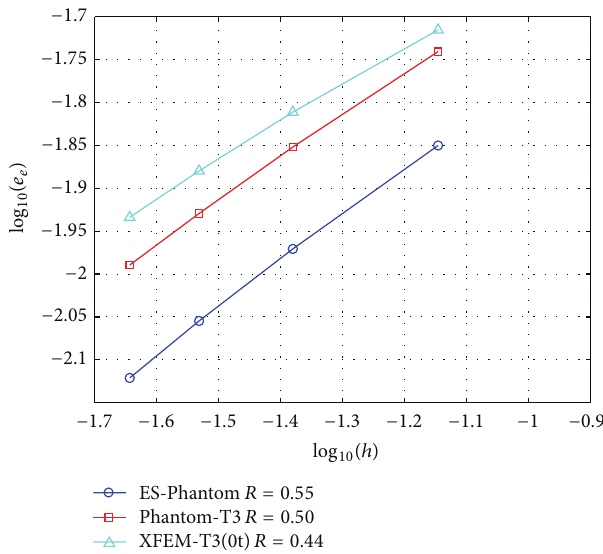
Figure 9: Strain energy for the sheet with edge crack under tension. shown in Figure 5 so that crack tip is guaranteed to locate on the element’s edge: nodes of smoothing domain 1 ( Ω nodes of smoothing domain 2 ( Ω